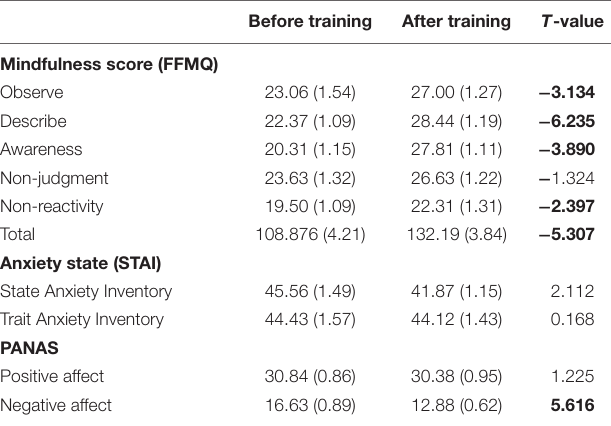
TABLE 1 | Demographic data for all subjects. TABLE 2 | The Five Facet Mindfulness Questionnaire (FFMQ), the State-Trait Anxiety Inventory (STAI), and the Positive and Negative Affect Schedule (PANAS) scores before and after meditation